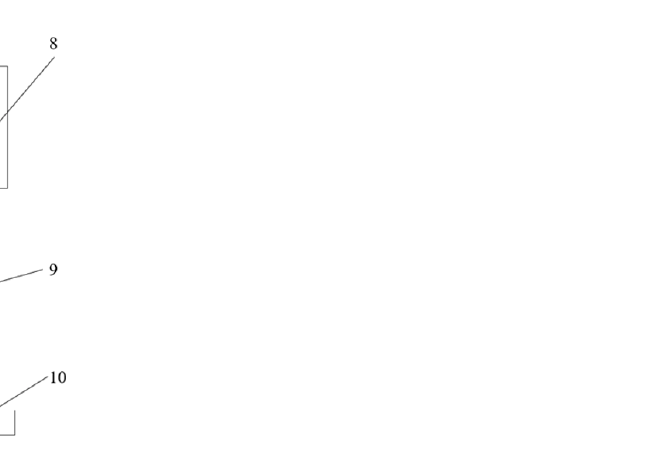
Figure 4. Schematic diagram of the steering system. 1 represents the hydraulic pump, 2 represents the electric steering wheel, 3 represents the full hydraulic steering gear, 4 represents the steering tie rod, 5 represents the left steering wheel, 6 represents the steering front axle, 7 represents the steering hydraulic cylinder, 8 represents the right steering wheel, 9 represents the unloading valve, and 10 represents the oil tank.